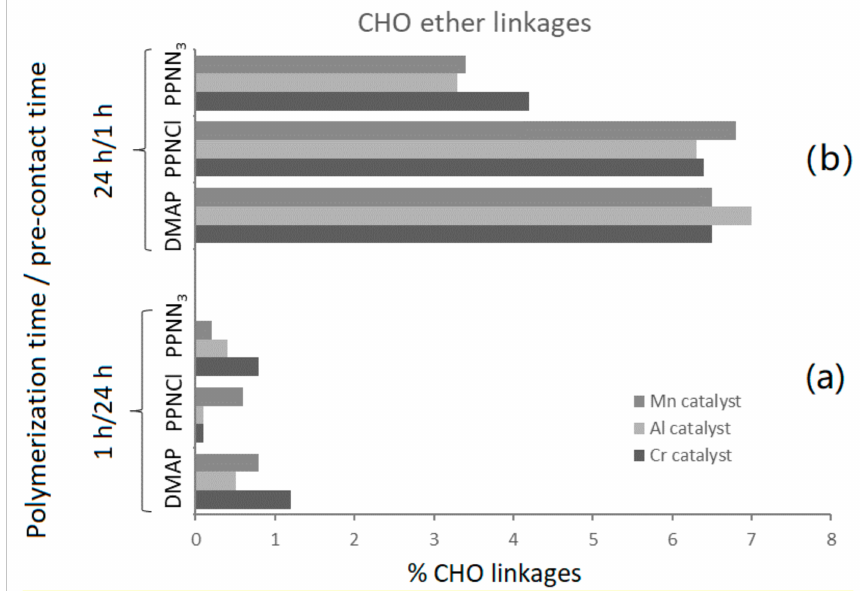
Figure 2. CHO–CHO ether linkage percentage for the di ff erent catalytic systems with a polymerization